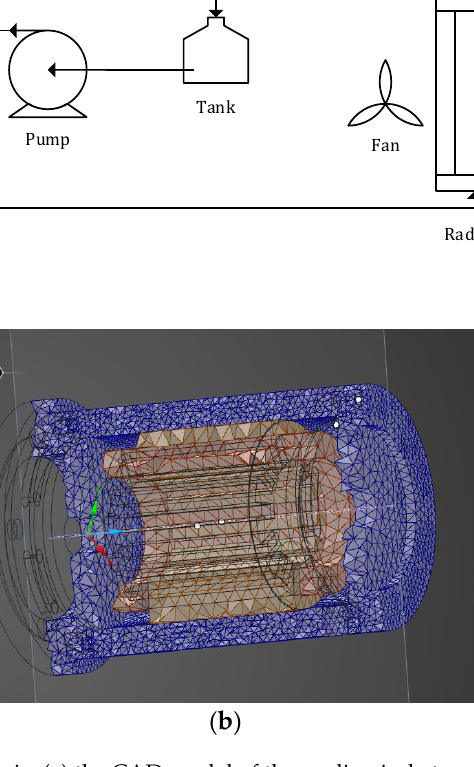
Figure 13. Cooling jacket and the FEM analysis: ( a ) the CAD model of the cooling jacket and SRM; ( b ) the mesh distribution for the FEM simulation.